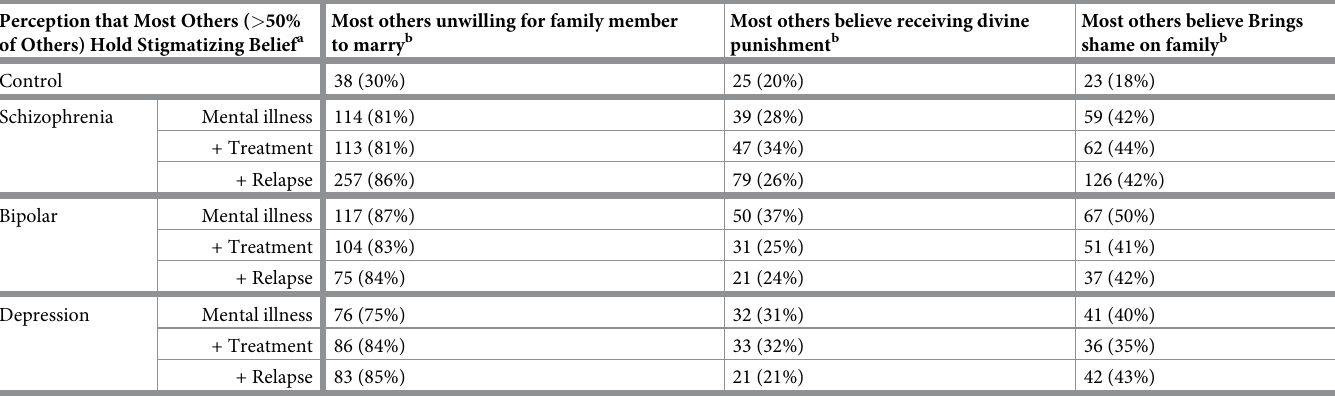
Results from the ordered logit regression models comparing perceived norms followed a similar pattern to that of personal beliefs ( Table 5 ). Across all outcomes, for every variant of symptom presentation, and for every variant of treatment description, a vignette describing any type of mental illness (untreated, treated, or treated with relapse) increased the odds that participants perceived more people in their village would be unwilling to allow the woman to marry into their families, participants perceived more people would believe that she brings shame upon her family, and participants perceived more people would believe that she was receiving divine punishment. As with the data on personal beliefs, in the case of bipolar illness, participants receiving the vignette about effective treatment were still more likely to endorse Table 3. Perceived stigmatizing beliefs of others by treatment